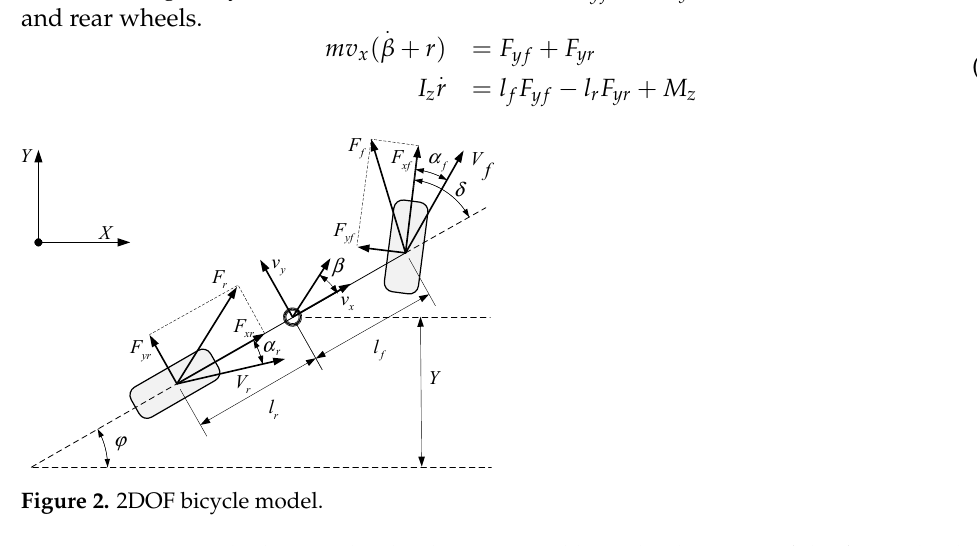
v and lateral velocity x